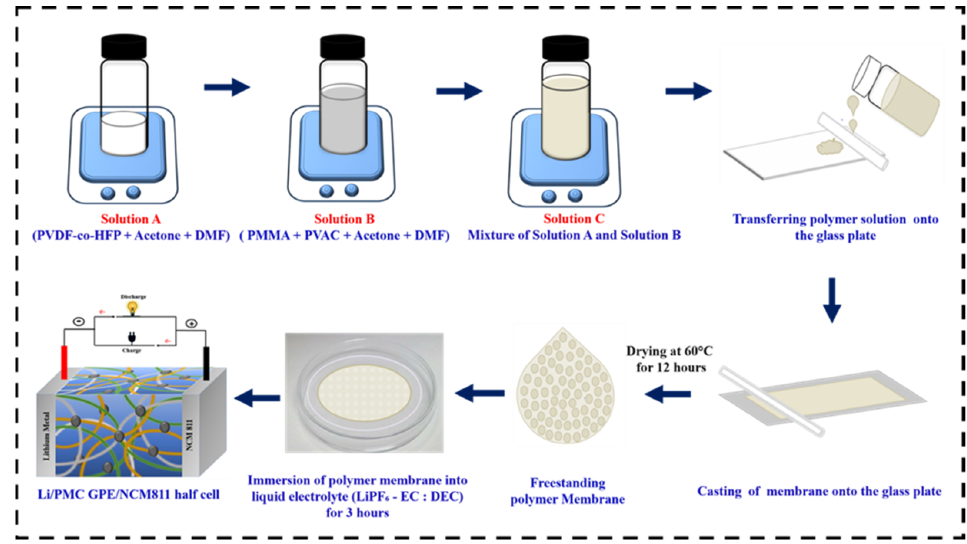
Figure 1. Schematic illustration of GPE synthesis.